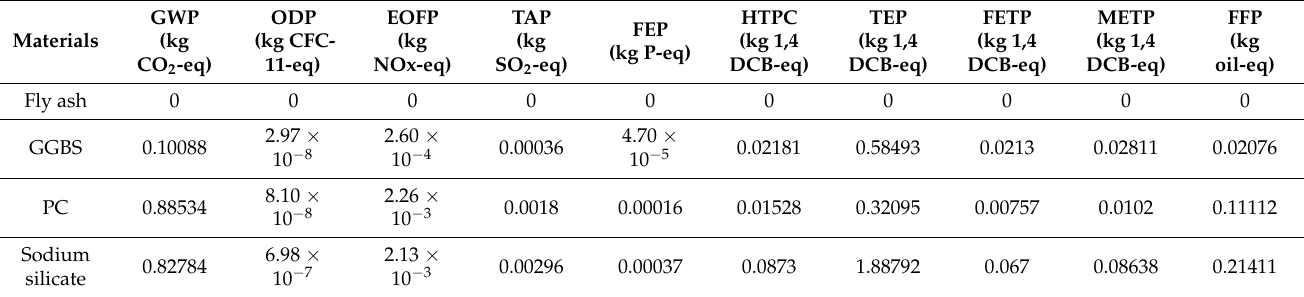
Figure 4. Process contribution (%) of AAC and PC concrete on midpoint impact categories. Table 5. Unit impact of each material on the midpoint impact